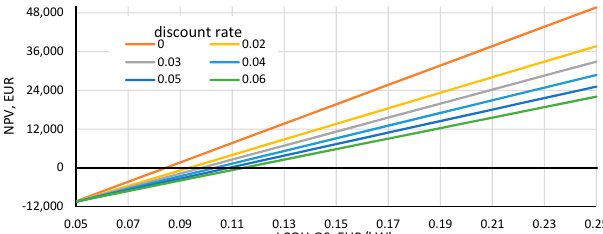
Figure 17. Net Present Value (NPV) as a function of LCOH.OS for different discount rate value, for distance = 0.5 km.